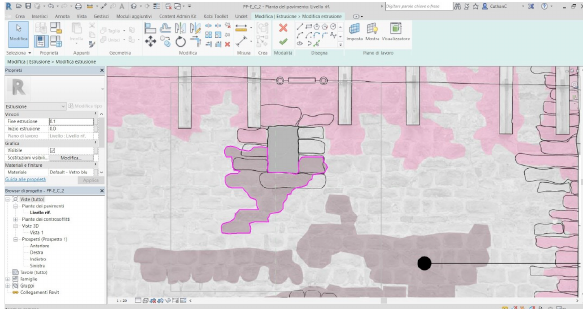
Figure 6. Graphic representation of the decay on the 3D model of the city walls (©